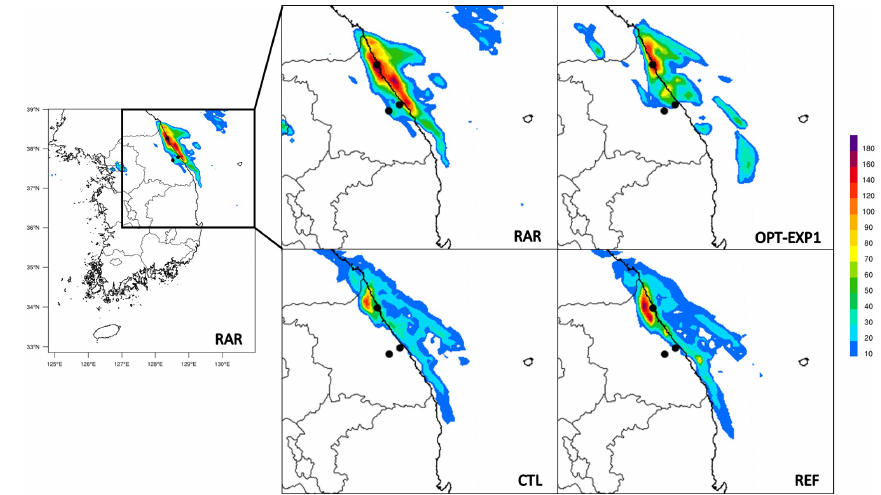
Figure 5. The spatial distribution of 12h accumulated precipitation for RAR, CTL, OPT-EXP1, and REF. Black dots depict locations of weather stations: Sokcho (S; 38.25 ◦ N, 128.56 ◦ E; 18.06m), Gangneung (G; 37.75 ◦ N, 128.89 ◦ E; 26.04m), and Daegwallyeong (D; 37.68 ◦ N, 128.86 ◦ E; 772.57m).